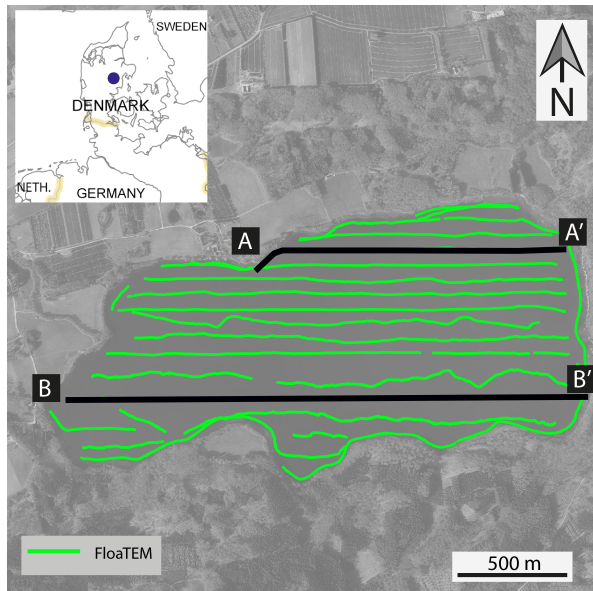
Figure 6. Survey region for the Ravnsø FloaTEM survey. Locations of the profiles in Fig. 7 are highlighted as solid black